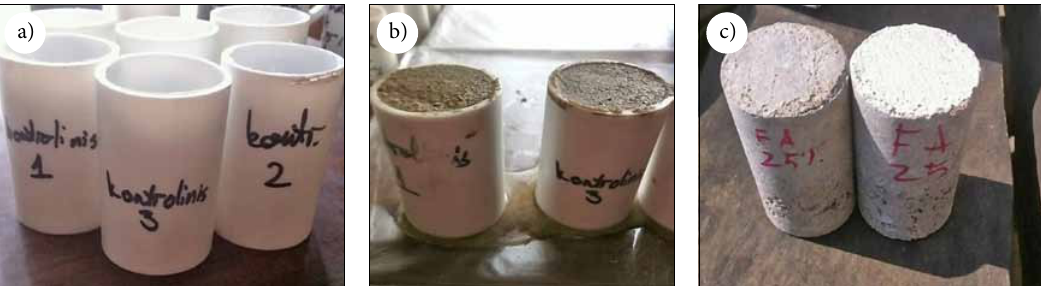
Fig. 3. Specimen preparation: a – tubular PVC; b – specimens removing surplus level with the shaped PVC edges; c – produced specimens taken out from PVC